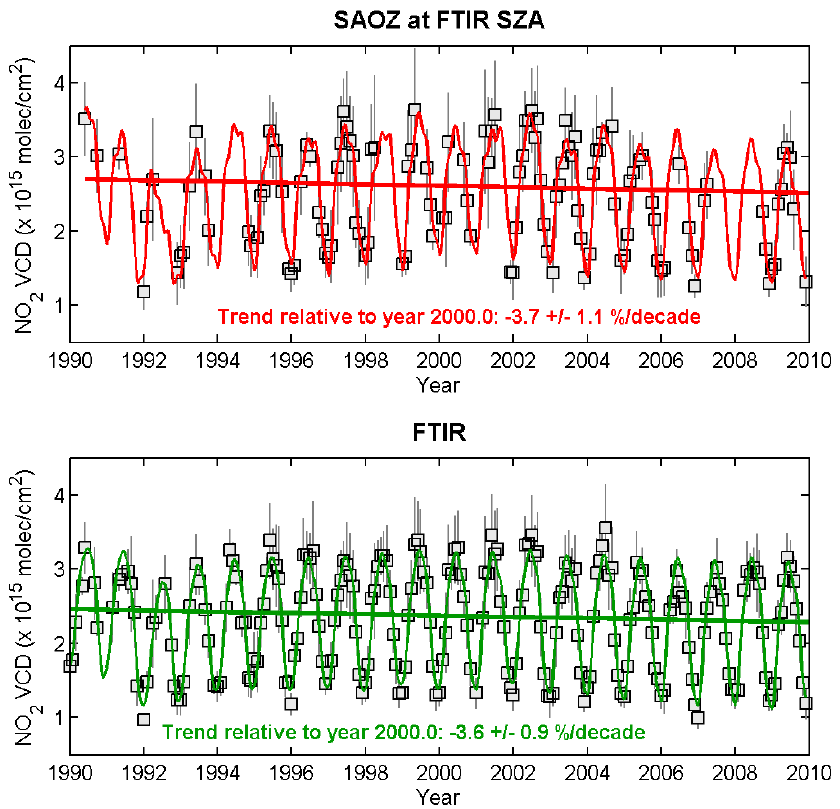
Figure 4: Results of the trend analysis over the 1990-2009 period using the ground-based UV-visible SAOZ and FTIR monthly mean NO 2 vertical column densities (VCD; grey squares). Twilight SAOZ columns are photochemically converted to the mean SZA of the FTIR measurements. Colored lines correspond to the linear trend (thick line) and to the NO 2 columns recalculated using the multiple linear regression model (thin line). The error bars correspond to the 1-sigma standard deviation.